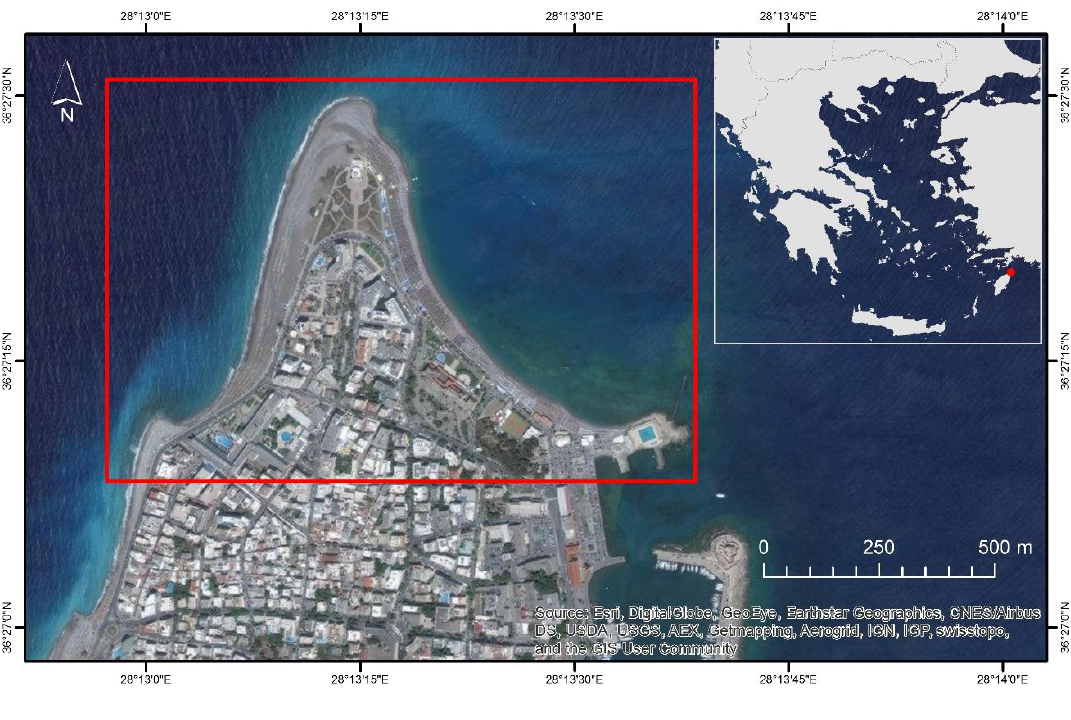
Figure 1. The study area of the Cape Mylon, Rhodes Island, Greece.